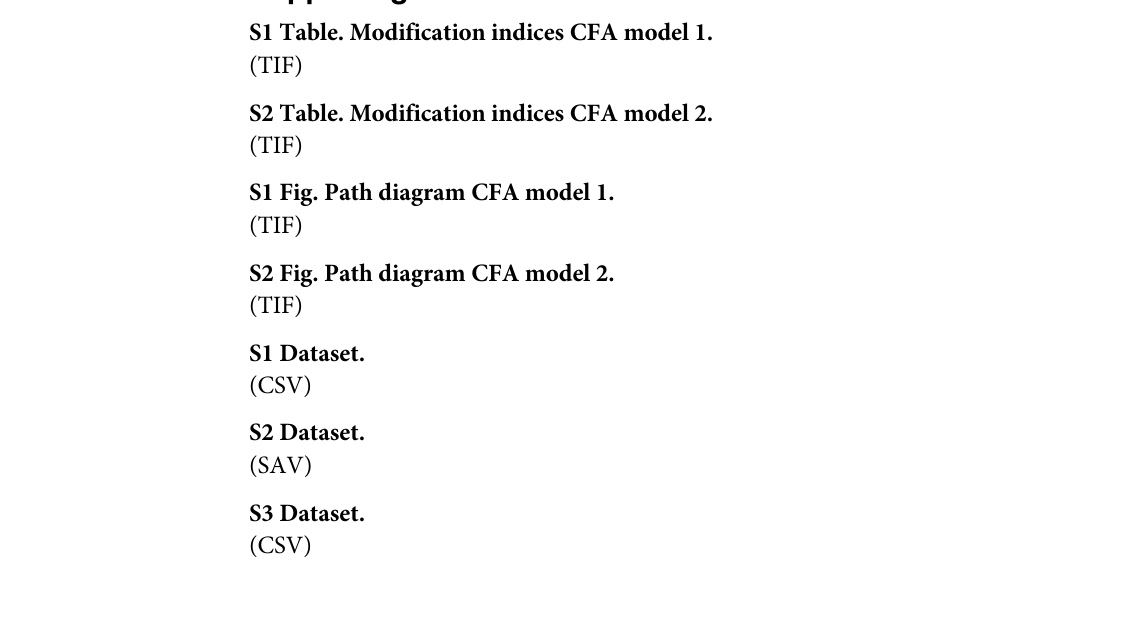
S1 Table. Modification indices CFA model 1. S2 Table. Modification indices CFA model 2. S1 Fig. Path diagram CFA model 1. S2 Fig. Path diagram CFA model